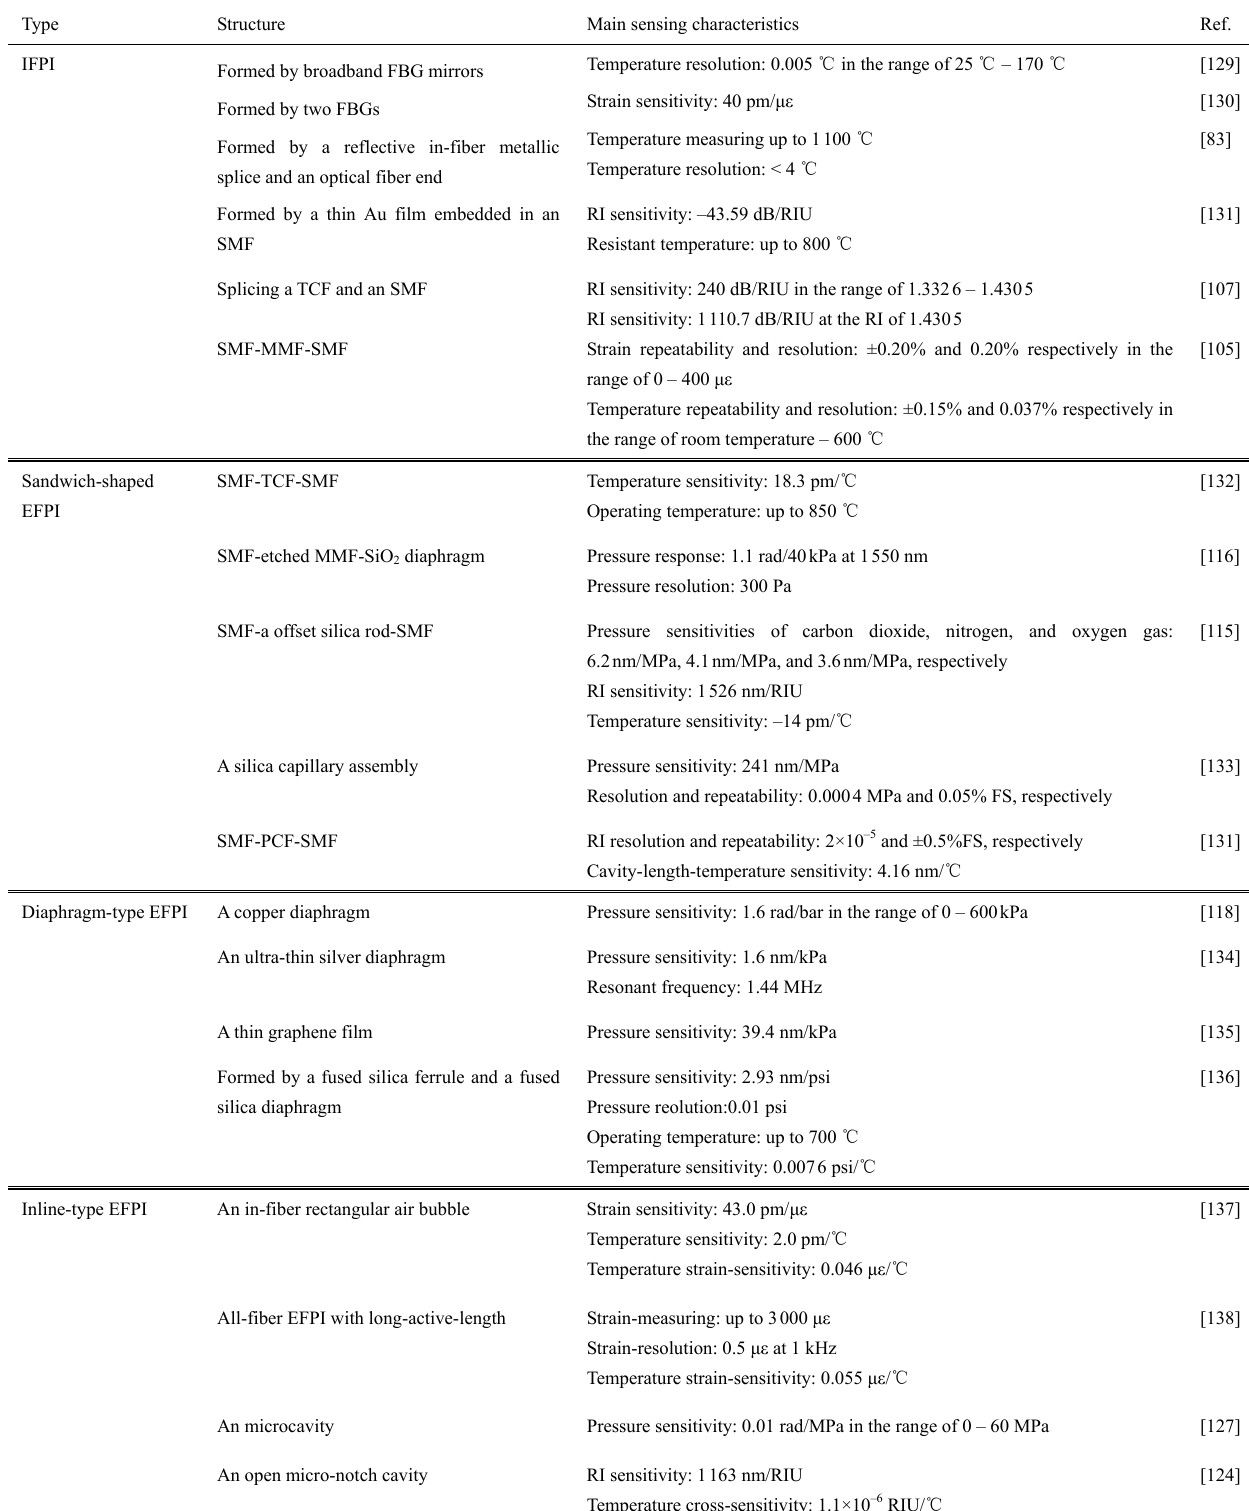
Table 5 Sensing characteristics comparison of different FP-based FOM